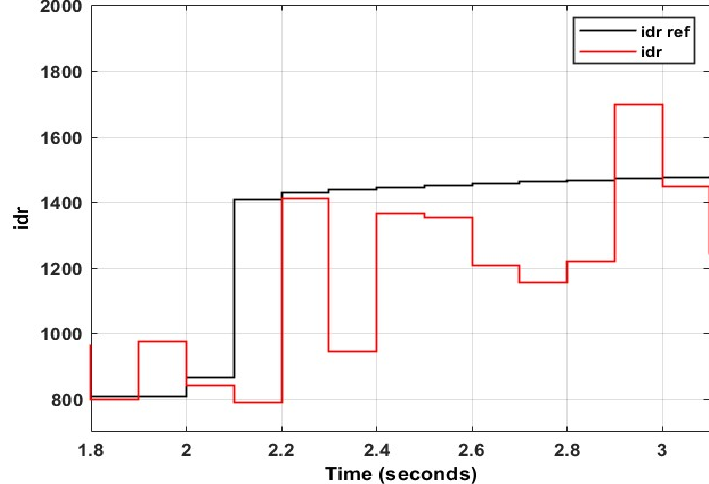
Figure 51. Rotor direct axis current ripple using DCI at 90% dip.